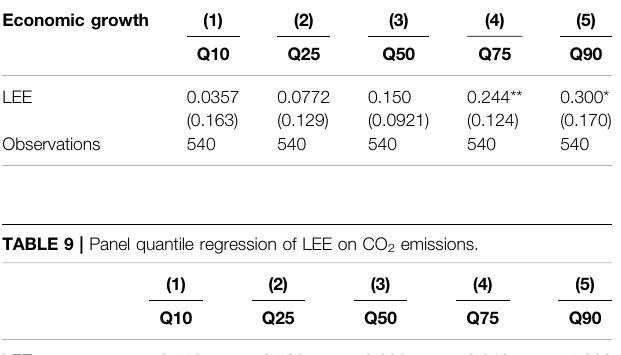
TABLE 10| RegressionofLEEonCO 2 emissionsandeconomicgrowth